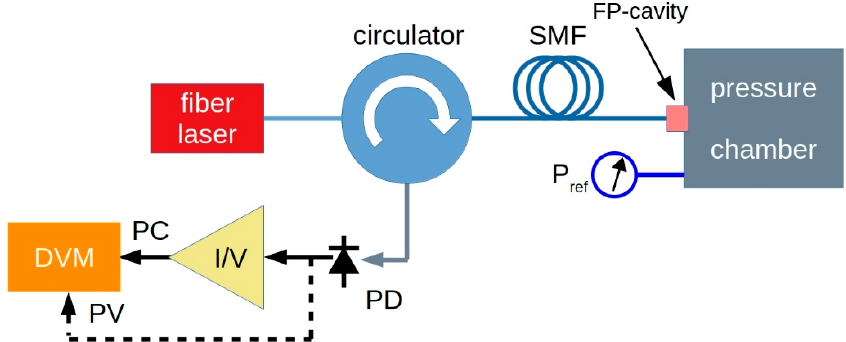
Figure 7. Schematic of the experimental set-up. An IR fiber laser is coupled to the FP cavity by means of a circulator. The interference signal is detected by an InGaAs photodiode (PD). Either photovoltage (PV) or photocurrent (PC) signal are acquired as a function of the pressure by a computer-controlled digital voltmeter (DVM). For photocurrent acquisition, a current-to-voltage (I/V) photodiode amplifier is inserted.